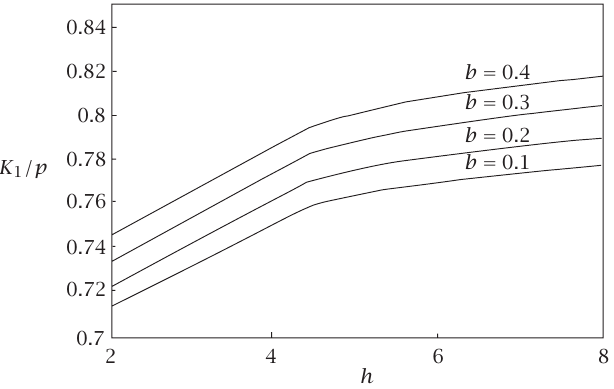
Figure 4.6 . Plot of K